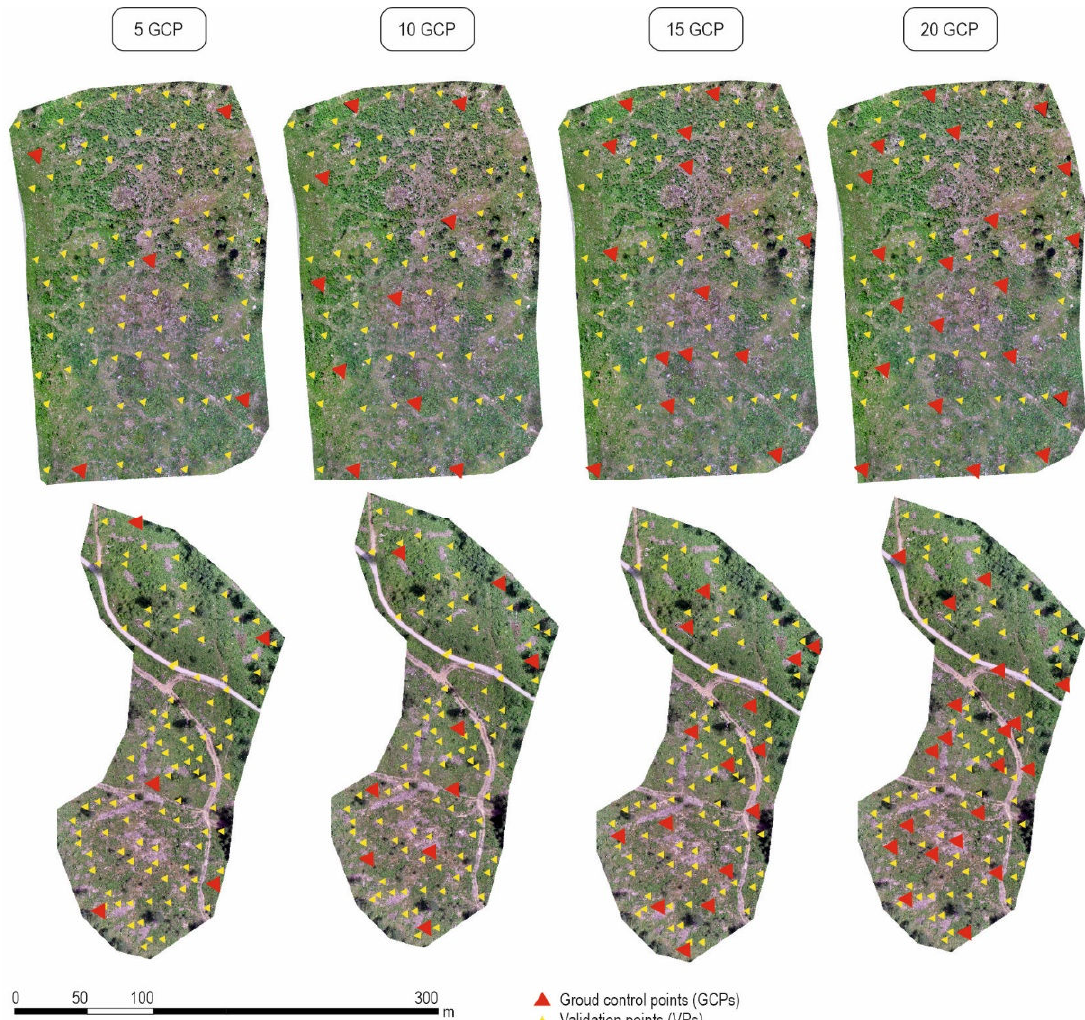
Figure 4. Variations in the number of GCPs in Plot 1 and Plot 2. The root mean square error was calculated for the coordinates of validation points gained from the orthophotos, point clouds and original imagery